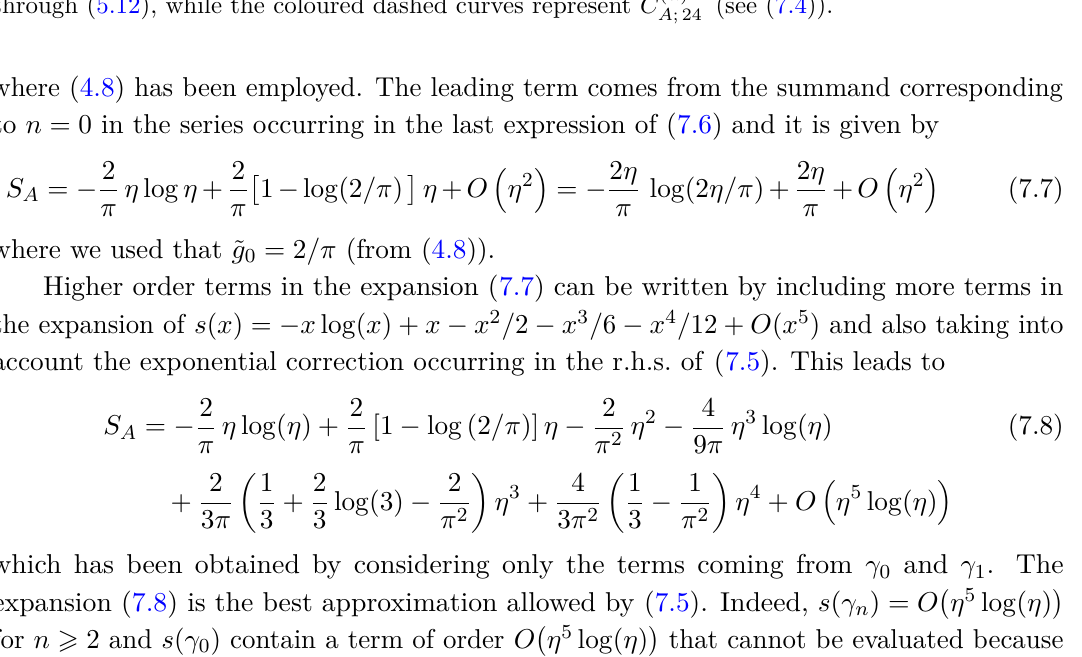
Figure 8. The quantities C ( α ) in the regime of small η . The data points are obtained numerically A through (5.12), while the coloured dashed curves represent e C ( α ) (see A ;24